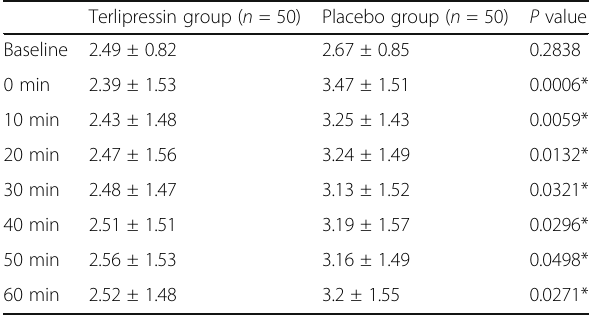
Table 8 Clinical outcome